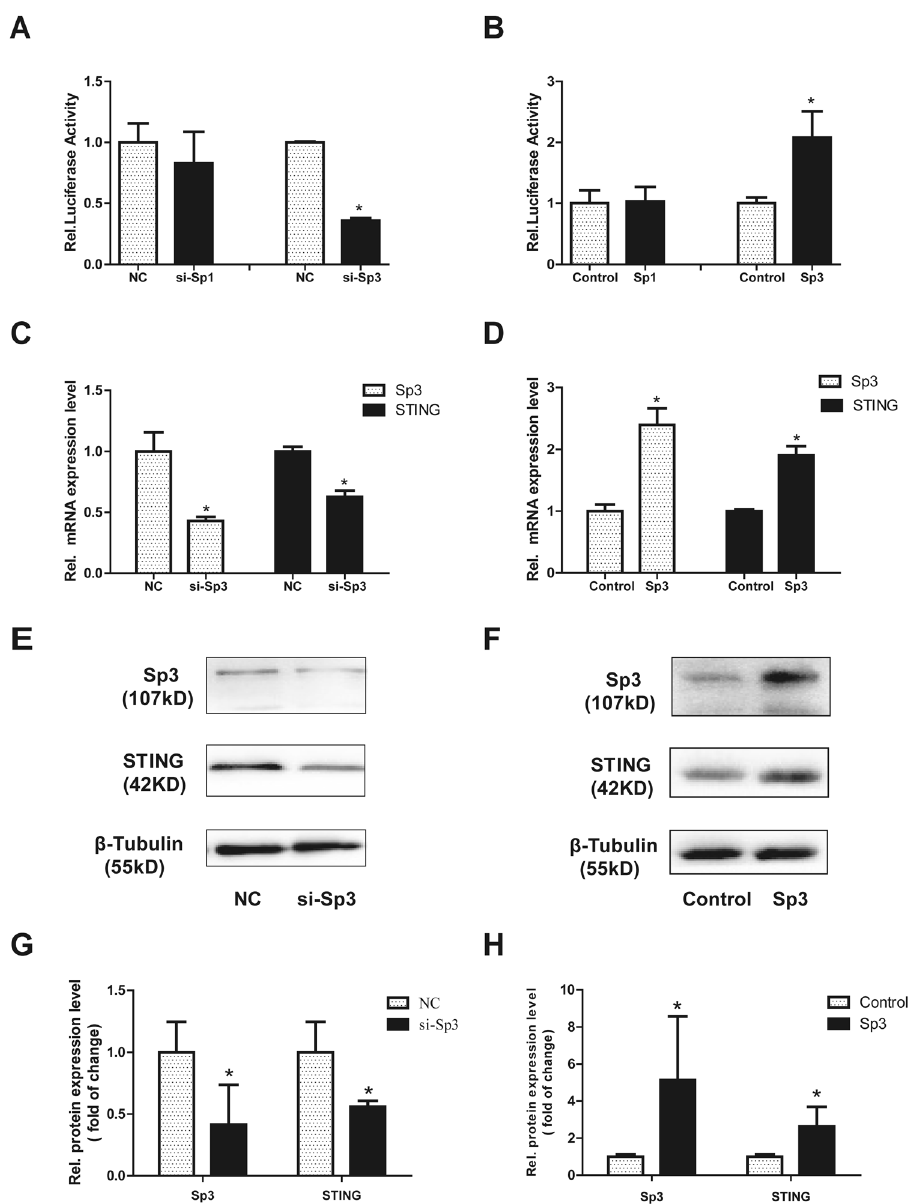
Figure 5. Sp3 but not Sp1 regulated the mSTING proximal promoter activity. ( A , B ) Overexpression of Sp1 or knockdown of Sp1 had no effect on the activity of the mSTING promoter. While knockdown of Sp3 by siRNA reduced the mSTING promoter activity to 35%, and overexpression of Sp3 increased the promoter activity by more than 2 folds. NIH3T3 cells were co-transfected with Sp1/Sp3 siRNA (50 nM) or Sp1/Sp3 expressing plasmid (200 ng) and pSTING-254(100 ng) and inner control pRL-TK (3 ng). After 24 h, luciferase activity was measured. ( C , E , G ) Reduction of endogenous Sp3 expression by siRNA decreased expression of the mSTING gene at mRNA and protein level. qRT-PCR and western blot were performed after siRNA/NC(50 nM) were transiently cotransfected into NIH3T3 cells. siRNA negative control was set as 1. Each bar represented the mean ± SD of three independent experiments. (n = 3, * P < 0.05 vs.NC). ( D , F , H ) STING protein expression increased by two times under overexpression of Sp3. Sp3 plasmid, pcDNA 3.1( + ) (4000 ng) were transiently cotransfected into NIH3T3 cells, and then qRT-PCR and western blot were performed. Each bar represented the mean ± SD of three independent experiments. (n = 3, * P < 0.05 vs.